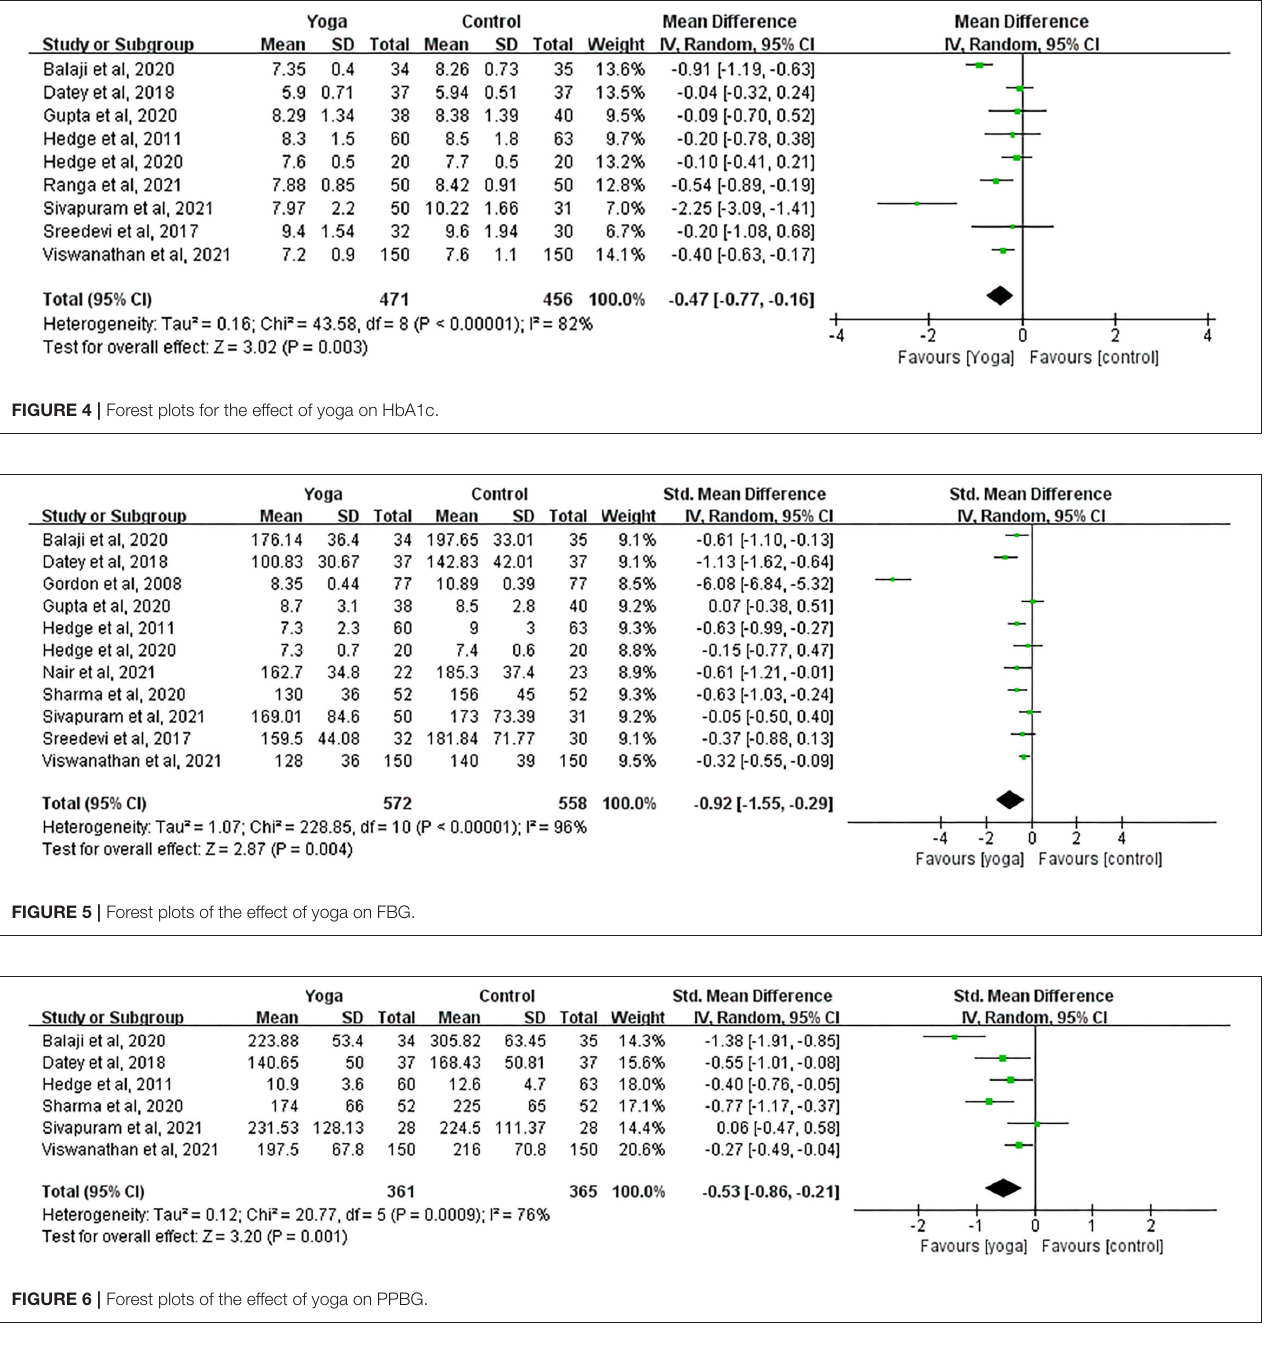
− 0.82, 0.13; Z = 1.44, p = 0.15). The heterogeneity